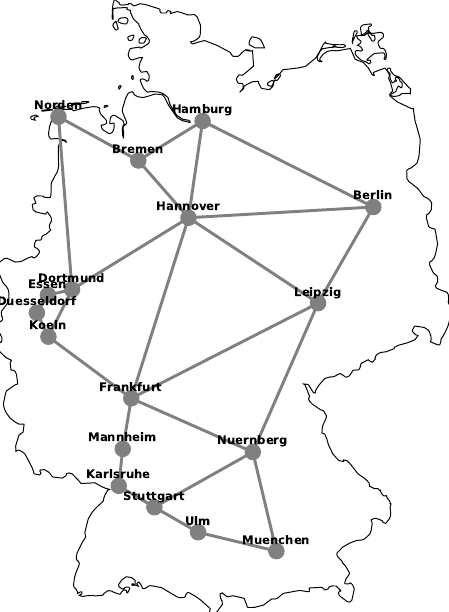
Figure 5. Schematic diagram of German national transmission optical backbone network.